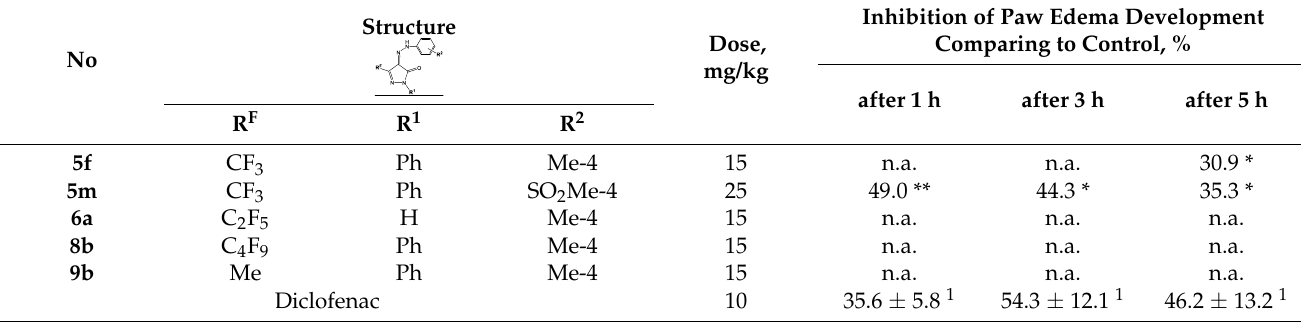
Table 9. Anti-inflammatory activity of compounds 5f,m, 6a, 8b, 9b .